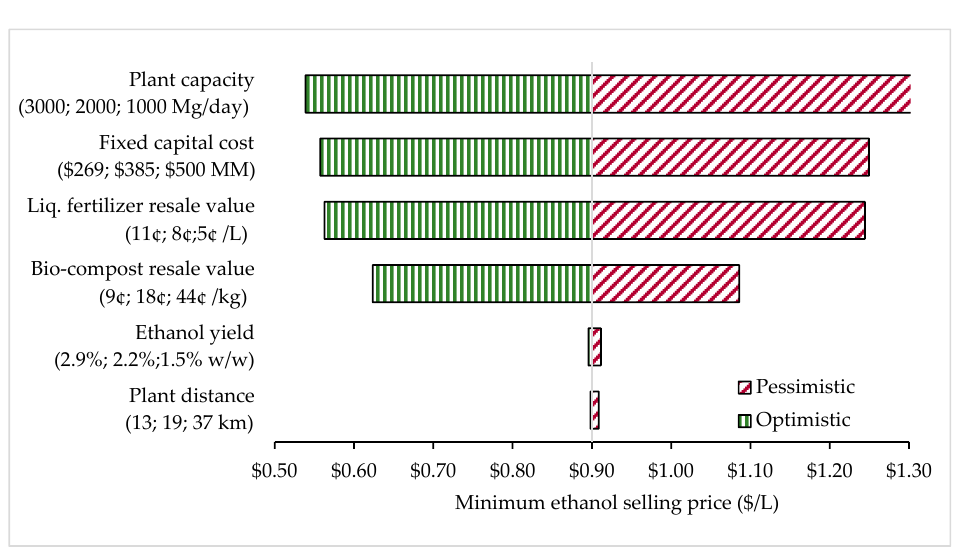
Figure 8. Sensitivity analysis for the scenario B FW fermentation process, without enzymes and a 2-step distillation system. Optimistic is the best-case scenario simulation and pessimistic is the worst-case scenario simulation.